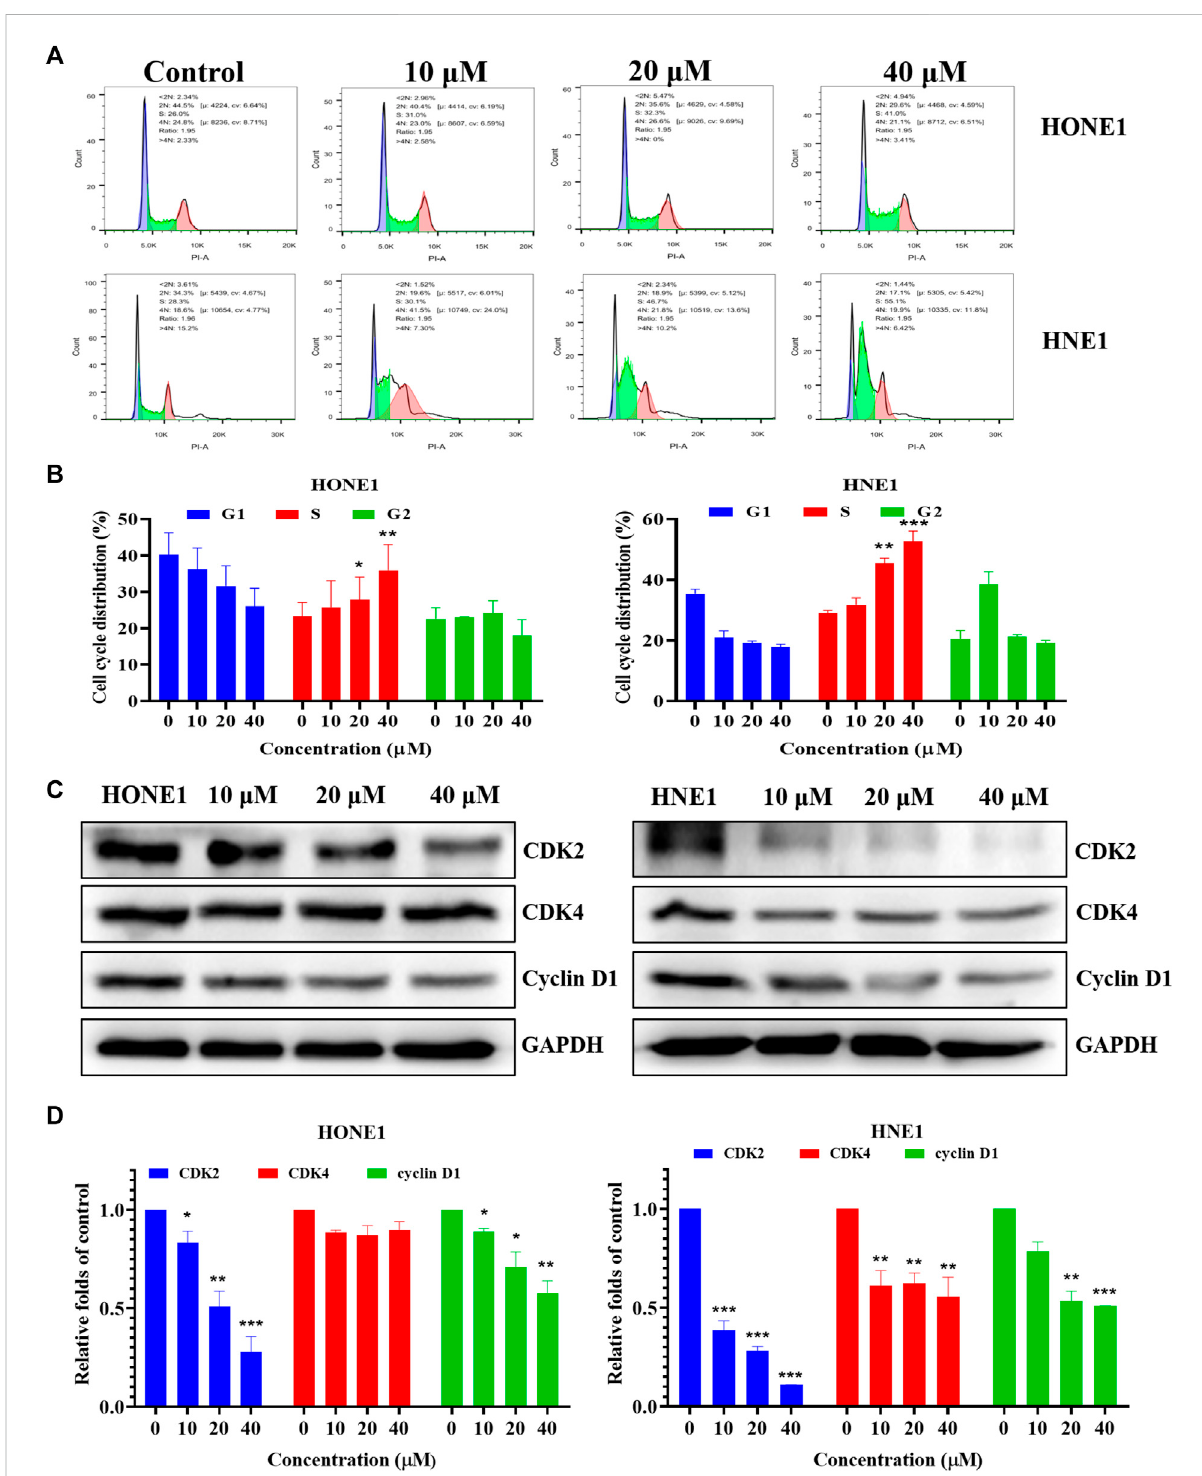
FIGURE 5 Icaritin arrests HONE1 and HNE1 cell cycles. (A) The cell cycle distribution of HONE1 and HNE1 cells was measured by fl ow cytometry after treatment with icaritin (10, 20, or 40 μ M) for 24 h. (B) The percentage of cell cycle distribution. (C) The expression of G1/S phase-related protein in HONE1 and HNE1 cells was measured by western blotting after treatment with icaritin (10, 20, or 40 μ M) for 24 h. (D) The quantitative analysis of protein bands. * p < 0.05, ** p < 0.01, *** p < 0.001 versus